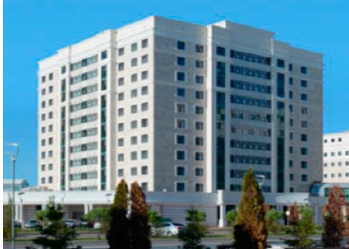
Figure 4. Business class building.